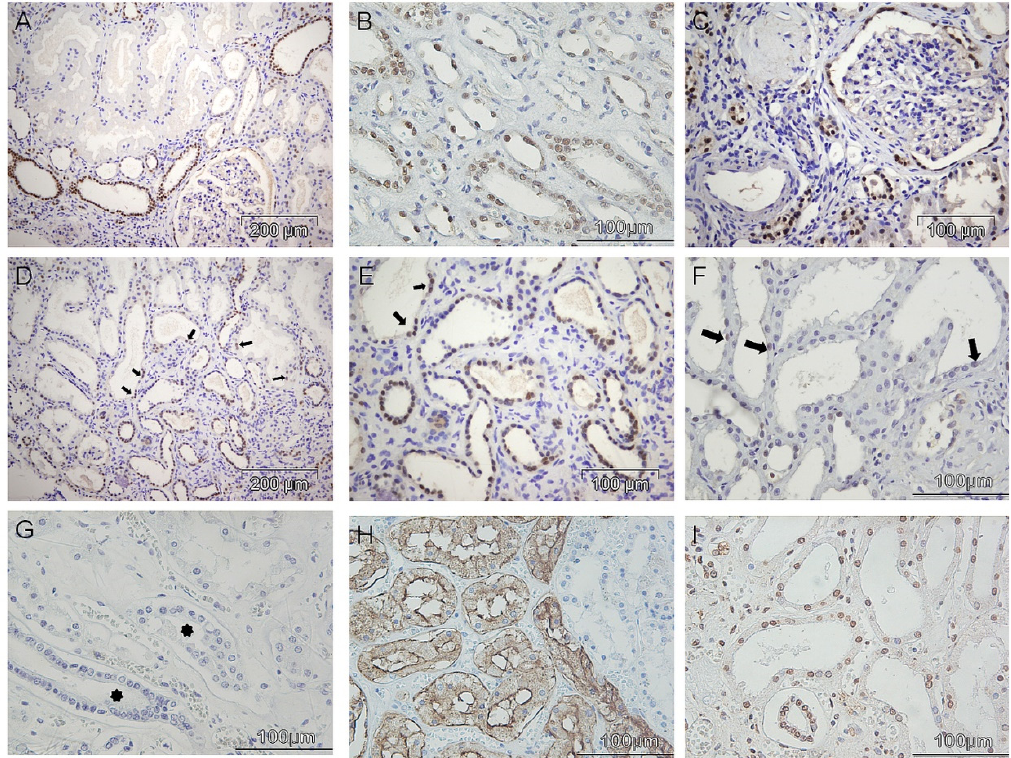
Figure 1. Immunohistochemical detection of PAX8 in kidney biopsies and autopsy cases. ( A ) Expression of PAX8 in the nuclei of distal tubules and in the parietal cells of Bowman capsule, as well as in the nuclei of few atrophic tubuli. ( B ) Collecting ducts and loop of Henle showed PAX8 nuclear positivity in the renal medulla. ( C ) The case of end stage kidney disease (ESKD) with PAX8 positivity in all the atrophic tubuli regardless of the nephronic segment, as well as in the parietal cells of Bowman capsule. ( D , E ) Widespread interstitial fibrosis and tubular atrophy; PAX8 detection in atrophic tubuli, as well as non-atrophic proximal tubular epithelial cells close to the area of renal interstitial fibrosis (arrows). ( F ) Biopsy sample of the patient with acute kidney injury (AKI) showed only a few proximal tubular epithelial cells marked as weakly PAX8 positive (arrows). ( G ) Autopsy case of AKI completely devoid of PAX8 staining, even considering kidney structures such as collecting ducts and distal tubuli (asterisks). ( H ) The same autopsy case of AKI showed CD10 membranous immunopositivity. ( I ) Preserved nucleophosmin expression in the same autopsy AKI case.